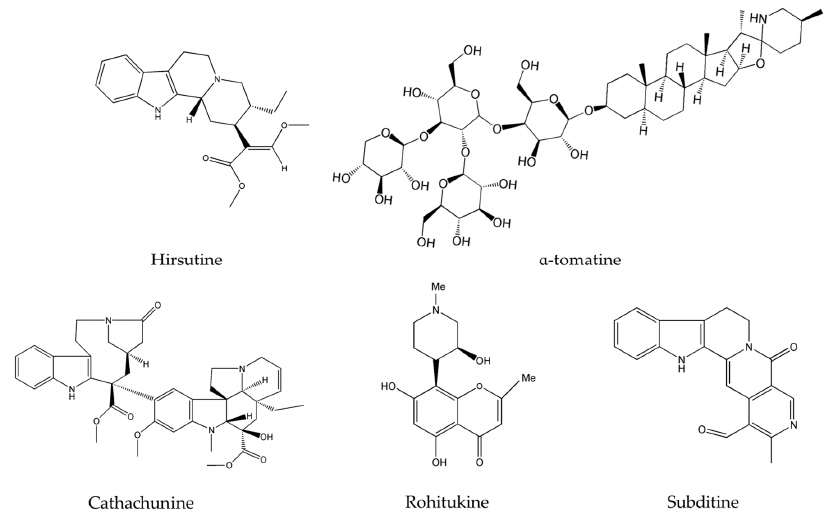
Figure 1. Chemical structures of hirsutine, α -tomatine, cathachunine, rohitukine and subditine.